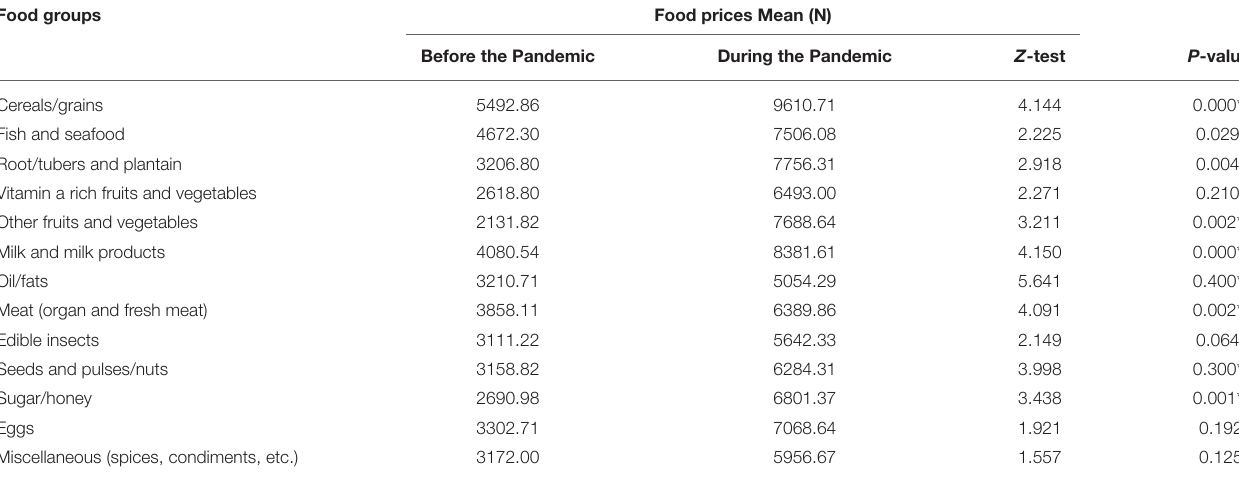
TABLE 4 | Food prices before and during the Pandemic. Food